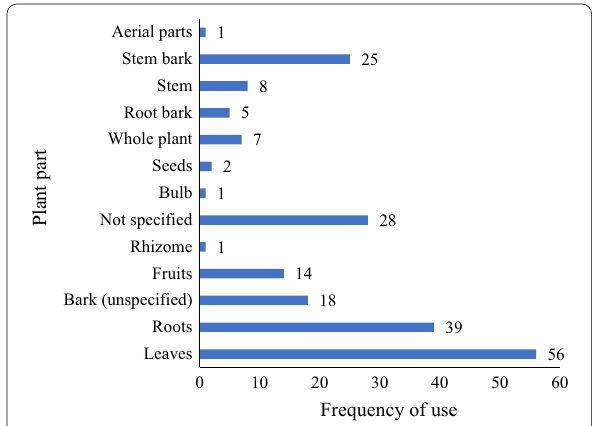
Fig. 2 Frequency of use of plant parts utilized in the management of cancer in Kenyan herbal medicine